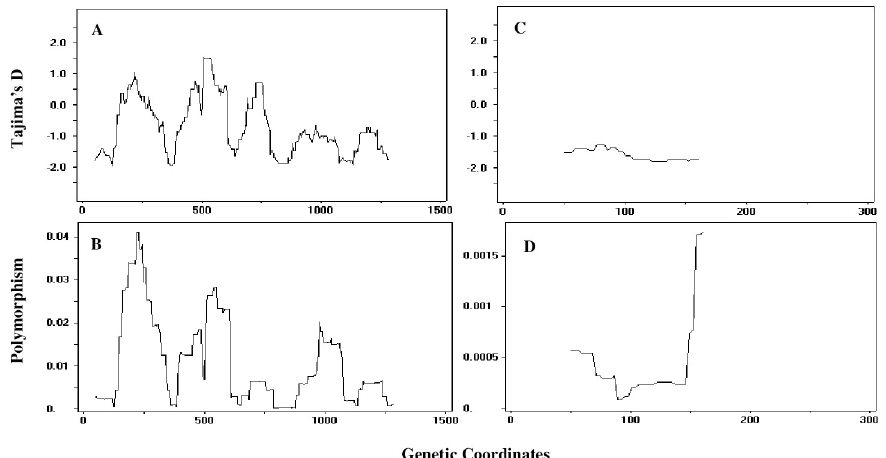
Fig 3. Tajima’s D and Nucleotide diversity across the Pvama1 ectodomain and Pvmsp1 isolates. Tajima’s D (A) and nucleotide diversity (B) were calculated across the Pvama1 ectodomain for global isolates. A sliding window (100 bp window and 3 bp step size) was used to achieve a high-resolution analysis. Pvmsp1 19 kDa region were analyzed for Tajima’s D (C) and nucleotide diversity (D) using a sliding window. All coordinates are based on Sal1 Pvama1 and Pvmsp1 19 reference sequences.